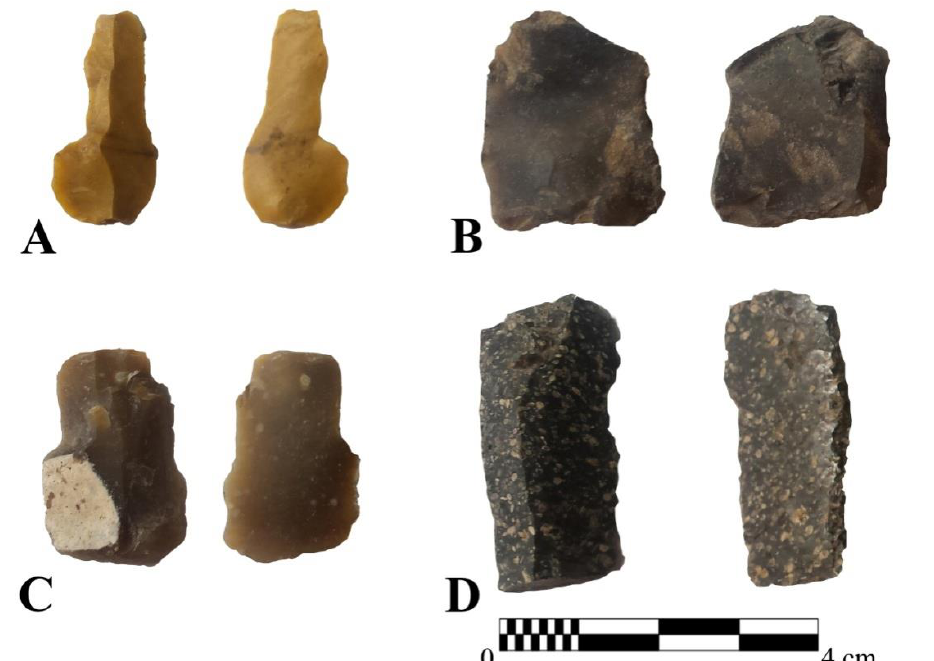
Figure 3. Detailed macroscopic images (dorsal and ventral) of some of the studied lithics from Limba-Oarda de Jos. A: flake, sample 4472. B: fragment ( débitage ), sample 4576(15). C: flake, sample 4446. D: blade, sample 4469 (from Rey-Solé et al.